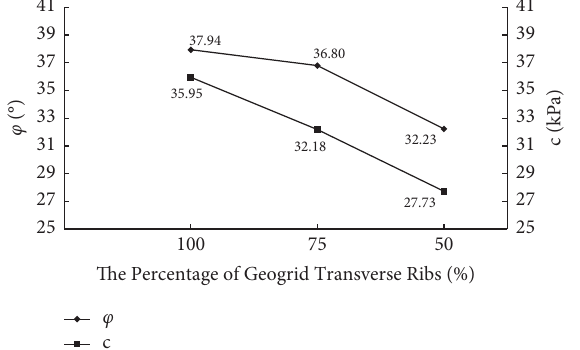
Figure 19: Variation curve of interfacial shear strength parameters under diferent percentages of geogrid transverse